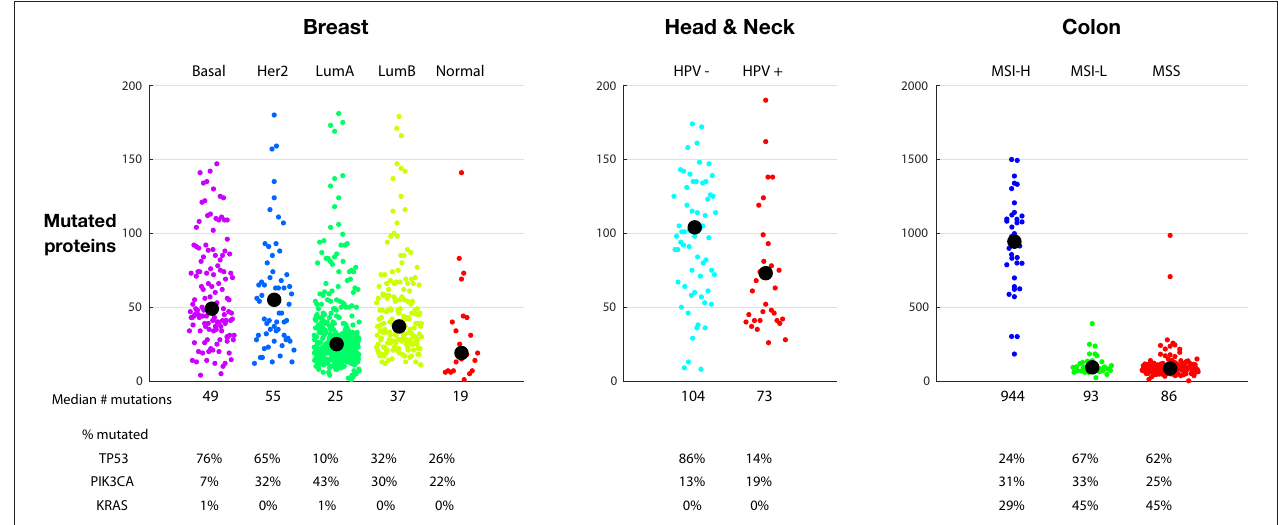
FIGURE 2 | Tumor mutations burden (TMB) in sub-classes of breast tumors (Left) , head and neck tumors (Middle) , and colon tumors (Right) . Each colored dot represents one tumor. Medians are listed and indicated by a black circle. The percentage of tumors with TP53, PIK3CA, and KRAS mutations is listed. The vertical scale of the colon tumor plot is different from the scale in the breast and head and neck tumor plots. TMB is defined as the number of proteins with a non-synonymous